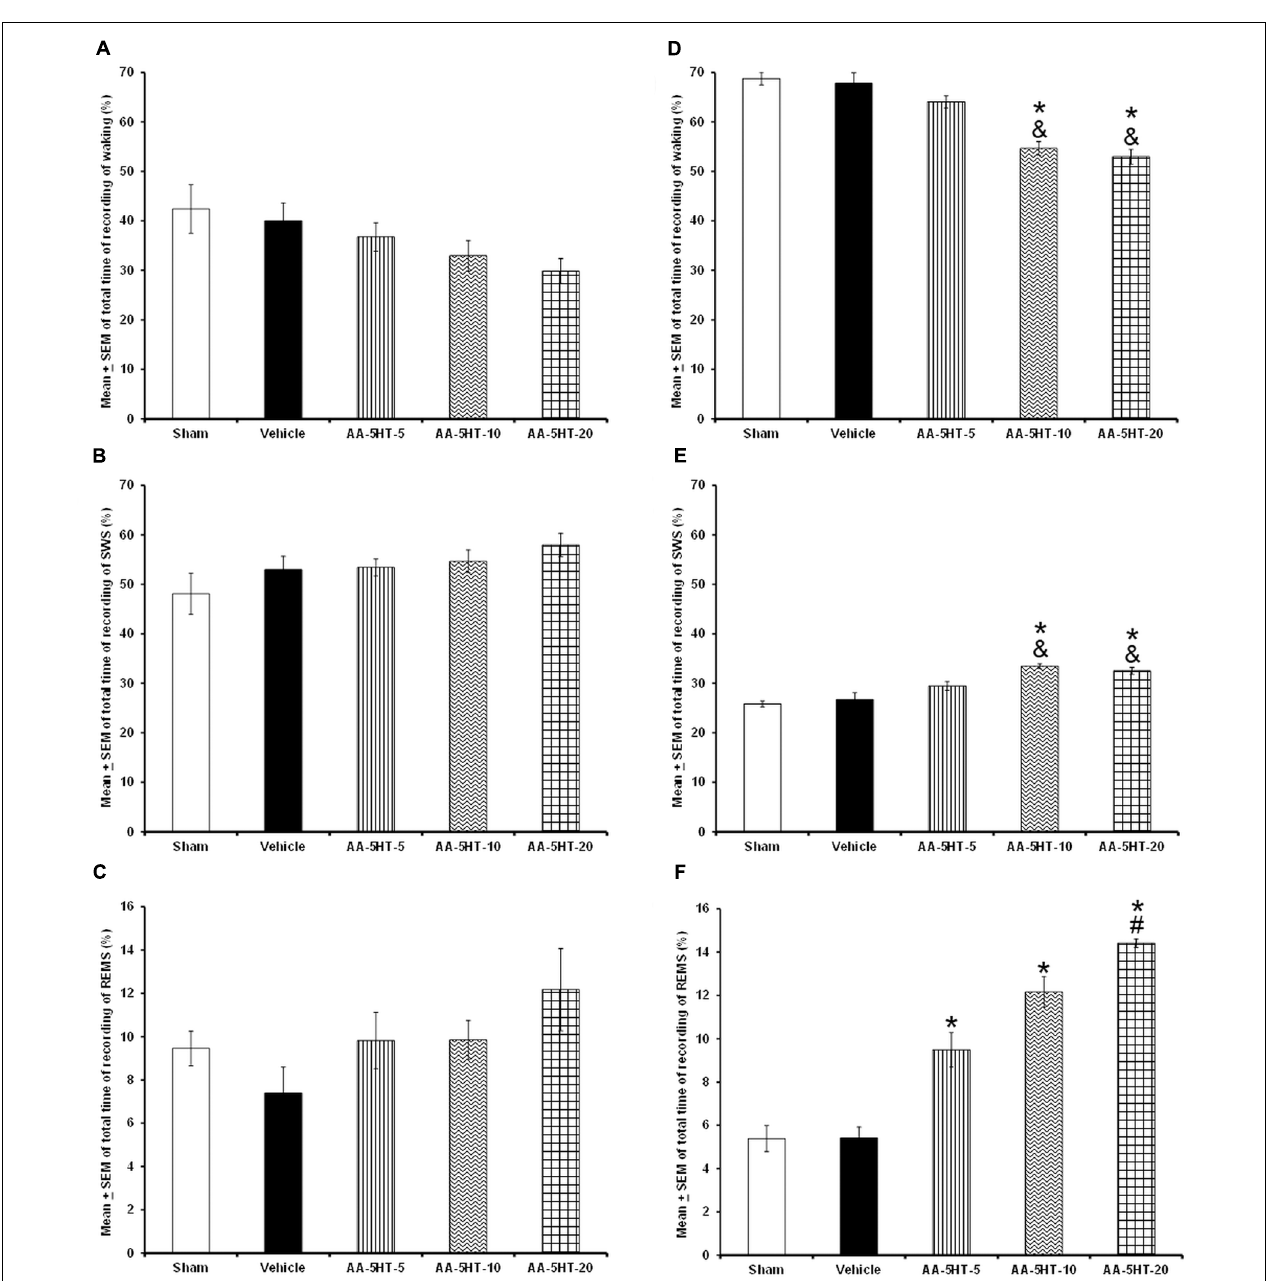
FIGURE 1 | Effects on total time (4 h of sleep recordings) of wakefulness (W), slow wave sleep (SWS), and rapid eye movement sleep (REMS) after experimental trials: Sham, vehicle or AA-5-HT (5, 10, or 20 mg/Kg; i.p.). No effects were observed in W, SWS, or REMS when AA-5-HT was injected during the lights-on period ( A–C , respectively). However, when administered at the beginning of the lights-off period, AA-5-HT decreased W and increased SWS and REMS ( D–F , respectively; Mean ± SEM ∗ vs. Sham/Vehicle, P < 0.05; & vs. AA-5-HT-5, P < 0.05; # vs. AA-5-HT-10, P < 0.05). Abbreviations: wakefulness (W), slow